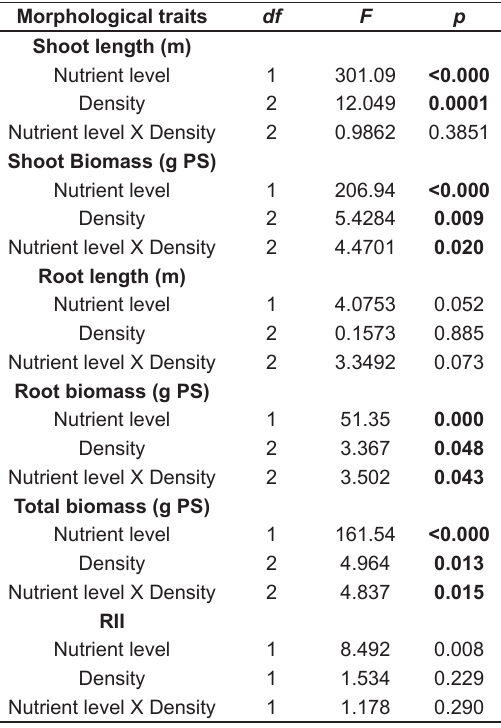
Table 1. Anova two-way results testing the effects of nutrients and densities, and their interactions with morphological traits of Alternanthera philoxeroides